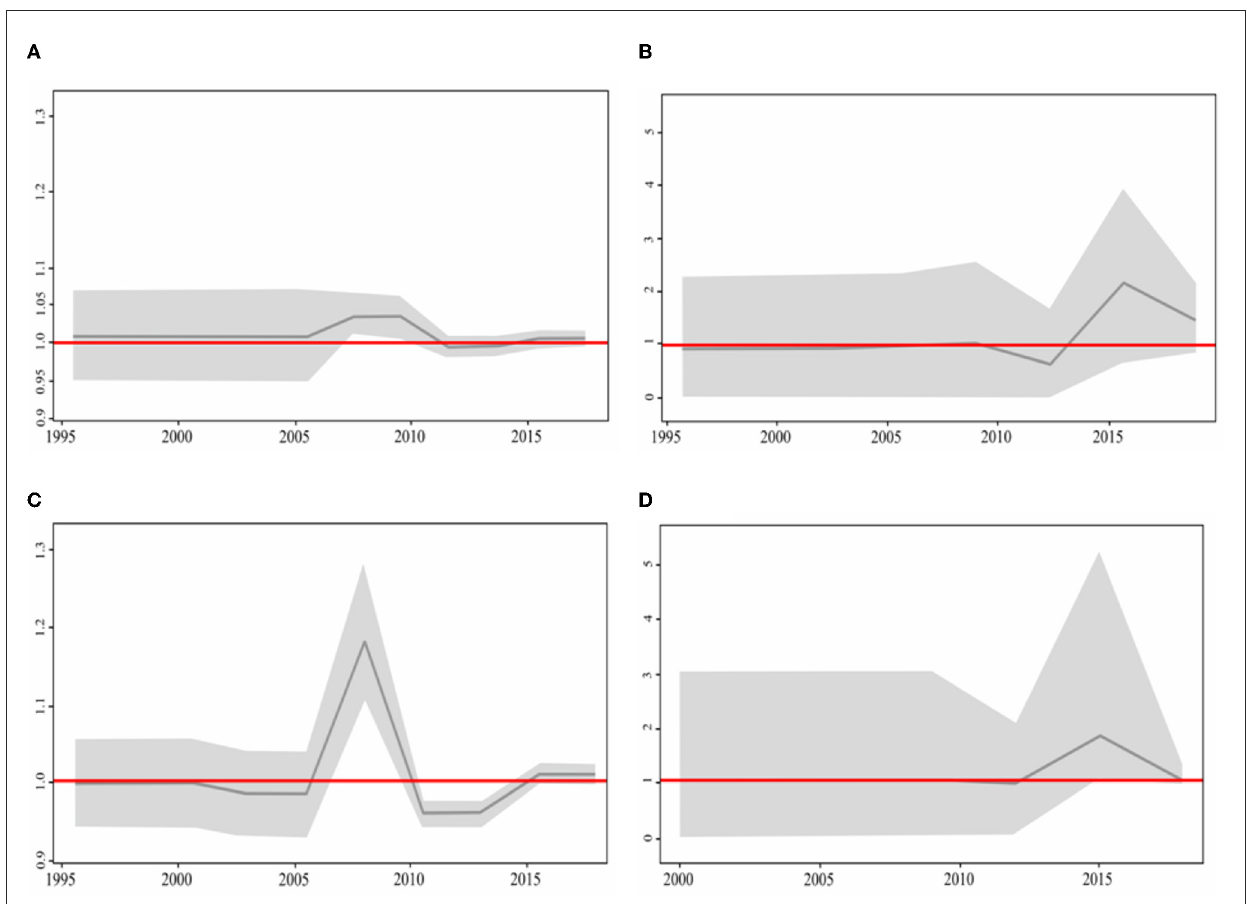
FIGURE3 Birth–death skyline plot based on the (A) Italian dataset together with the subclade of Central European sequences, (B) Central European dataset, (C) Europa 3, and (D) Africa 3. The BDSKY model was used and implemented in BEAST2 v2.6.5. The red line delineates the cut-off value of Re = 1. The shaded area represents 95% confidence intervals of Re estimates over time. The x-axis represents time in years and the y-axis the Re